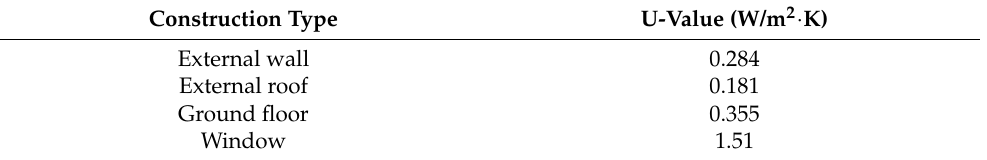
Table 2. U-value of the building load model.